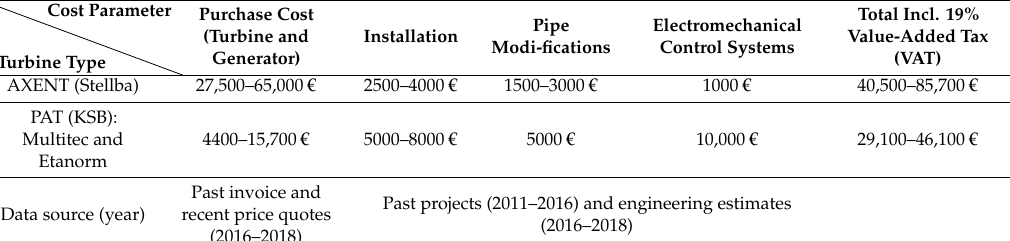
Table 2. Summary of cost parameters for AXENT turbines and